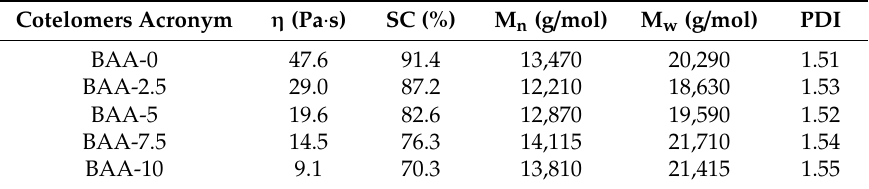
Table 2. Dynamic viscosity, solid content and molecular weights of BAA cotelomers. Cotelomers